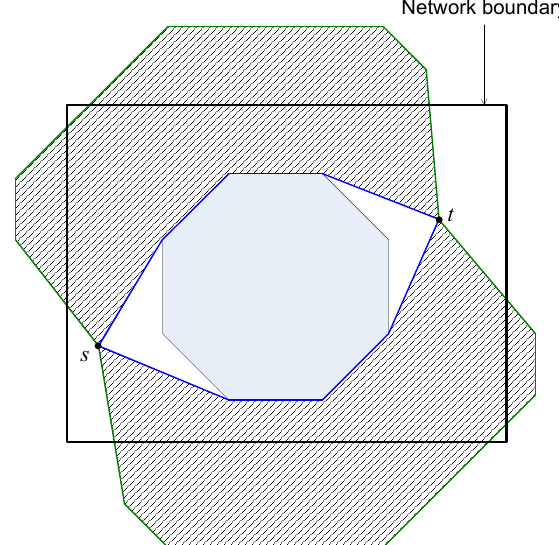
Figure 6. When (cid:101) is too large, the trajectory of the Euclidean routing paths may exceed the network boundary